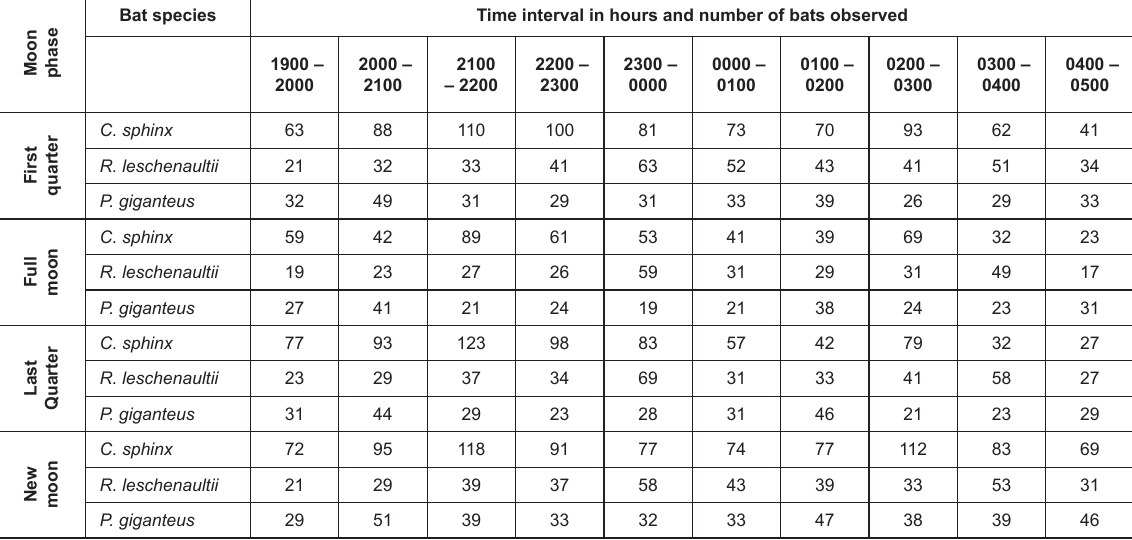
Table 4. Foraging patterns of pteropodid bats with reference to moon